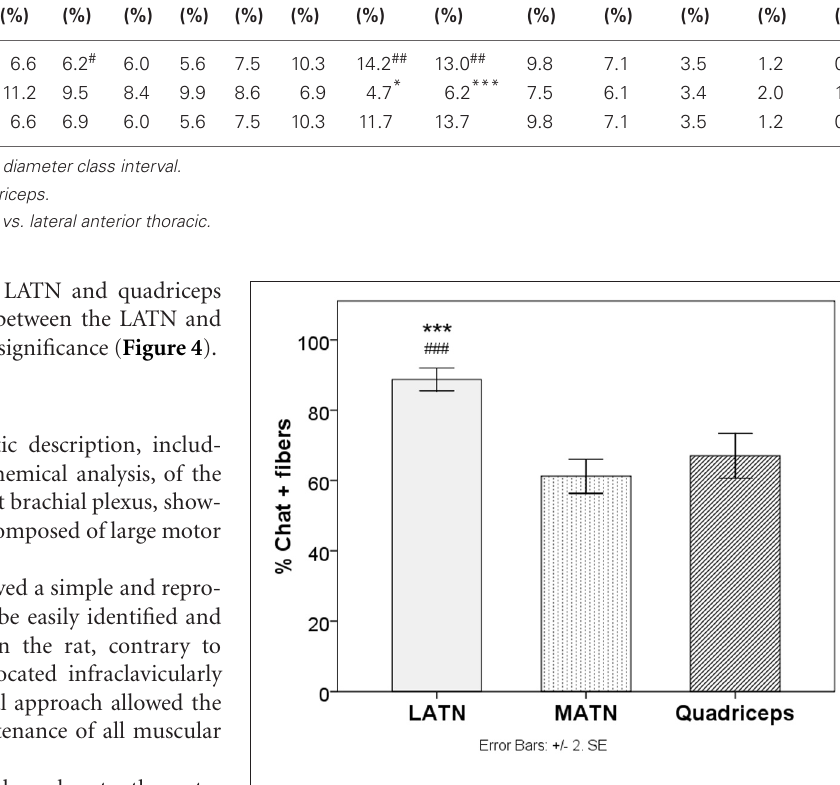
FIGURE 4 | Immunohistochemical analysis. Quantitative analysis of the percentage of ChAT positive fibers in study nerves. LATN, Lateral Anterior Thoracic Nerve; MATN, medial anterior thoracic nerve. ∗∗∗ p < 0 . 005 vs. quadriceps. ### p < 0 . 005 vs. lateral anterior